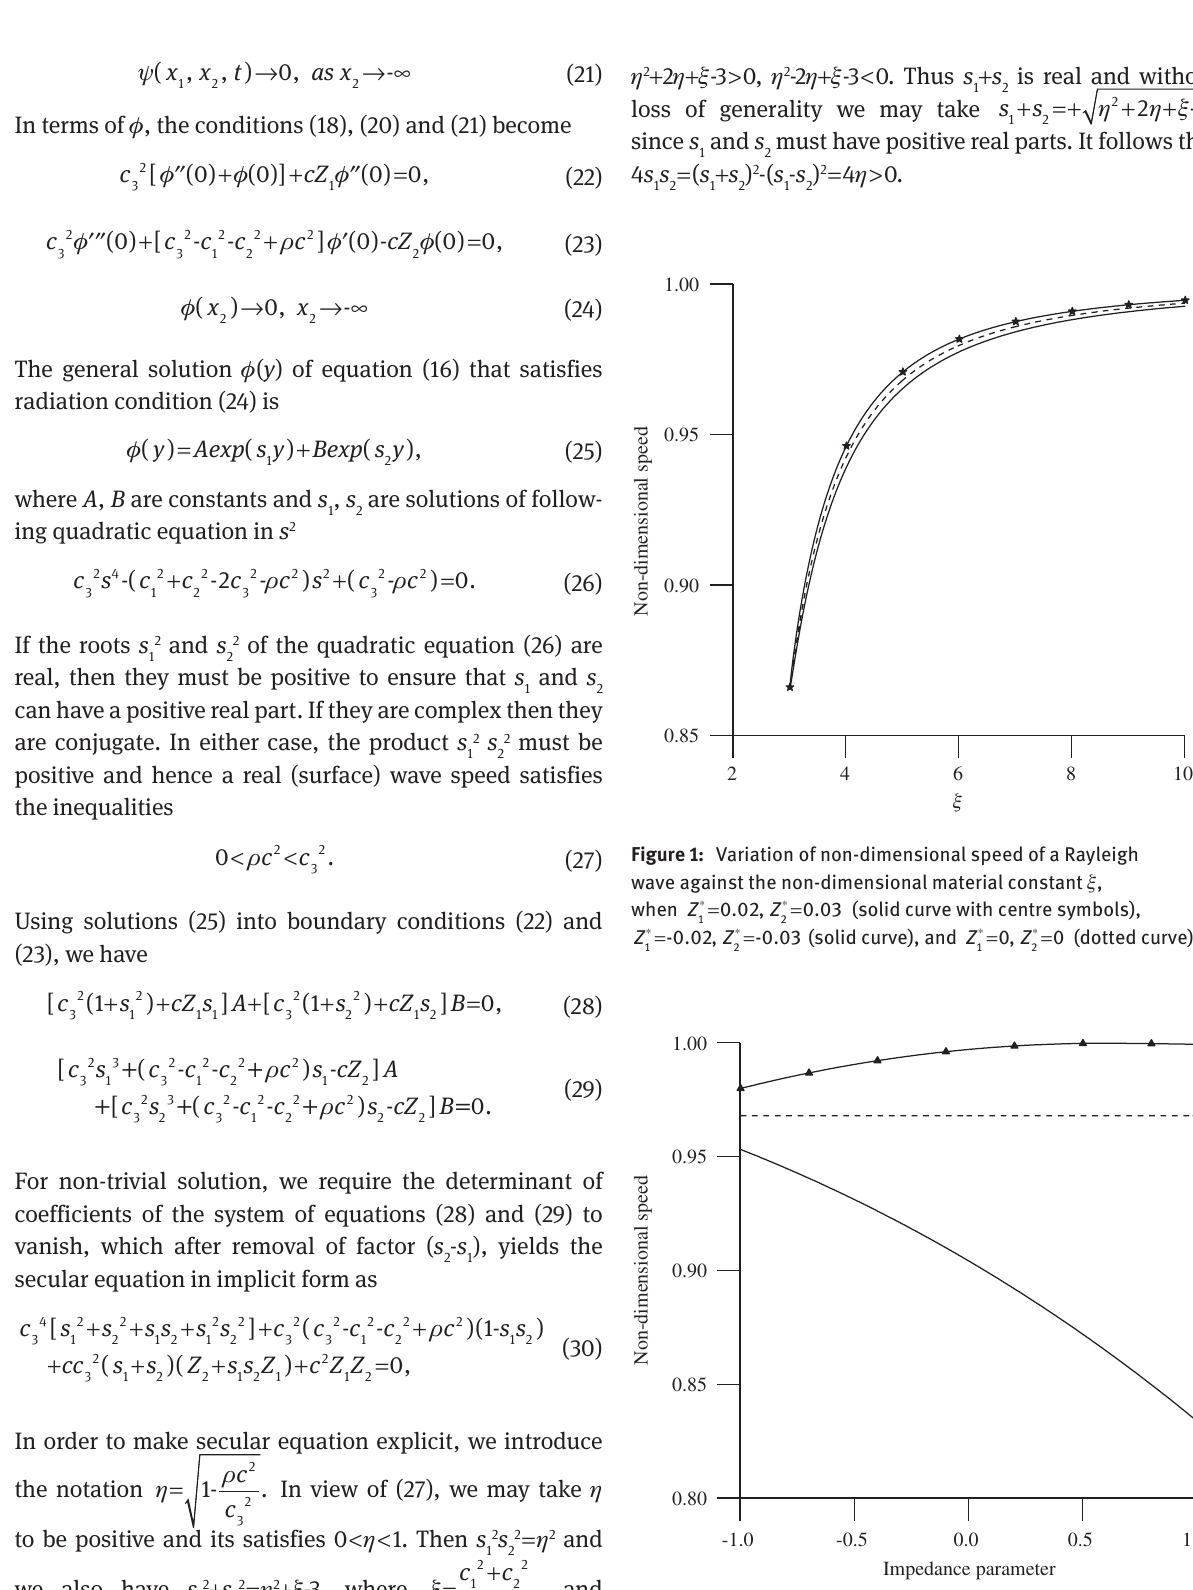
, Z when ξ = 0 and for ∗ = 1 -0.5 Z (solid curve), and ∗ = 2